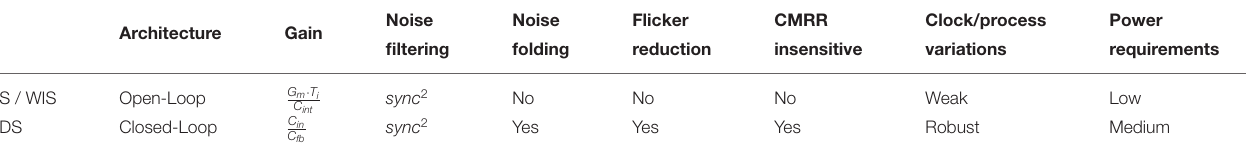
TABLE 1 | Noise-folding aware structures